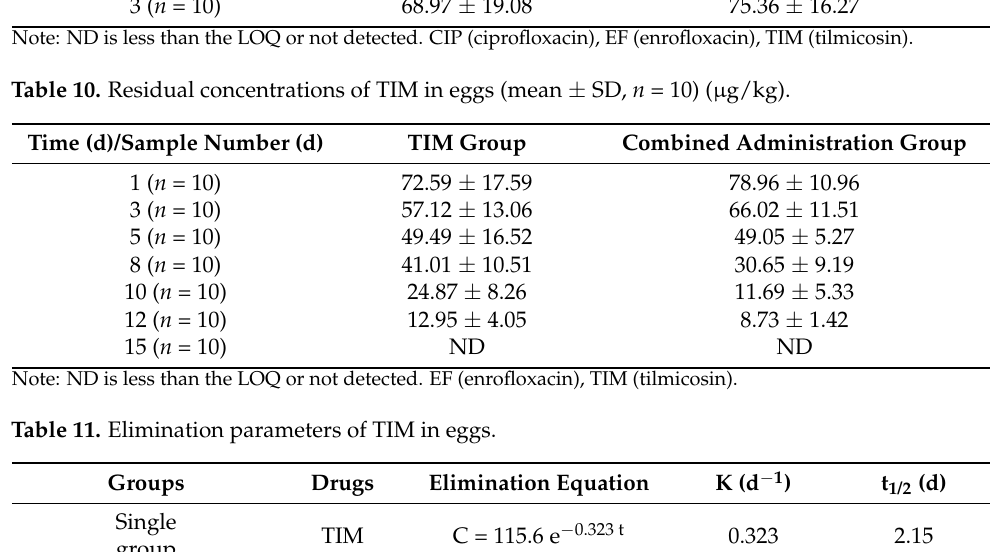
Table 9. Residual concentrations of TIM in eggs (mean ± SD, n = 10) ( µ g/kg). Time (d)/Sample Number (d)